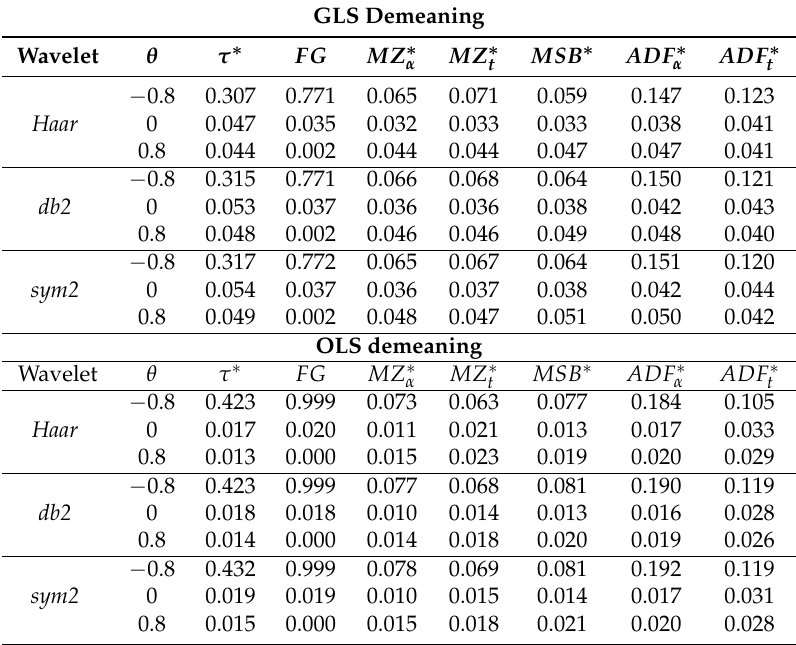
Table 5. The size comparison of the OLS and GLS demeaning with sample size T = 100. GLS